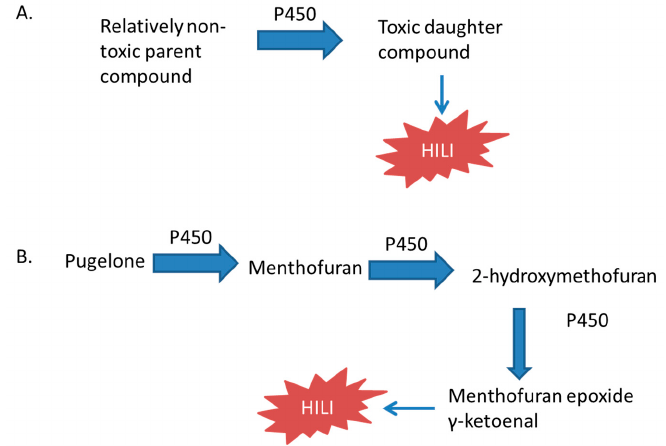
Figure 3. The effect of compounds metabolized by the P450 system on toxicity. The parent compound can be the herbal supplement itself or a co-administered FDA-approved drug. ( A ) Schematic of the general mechanism; ( B ) a specific example discussed in the text [22–24].